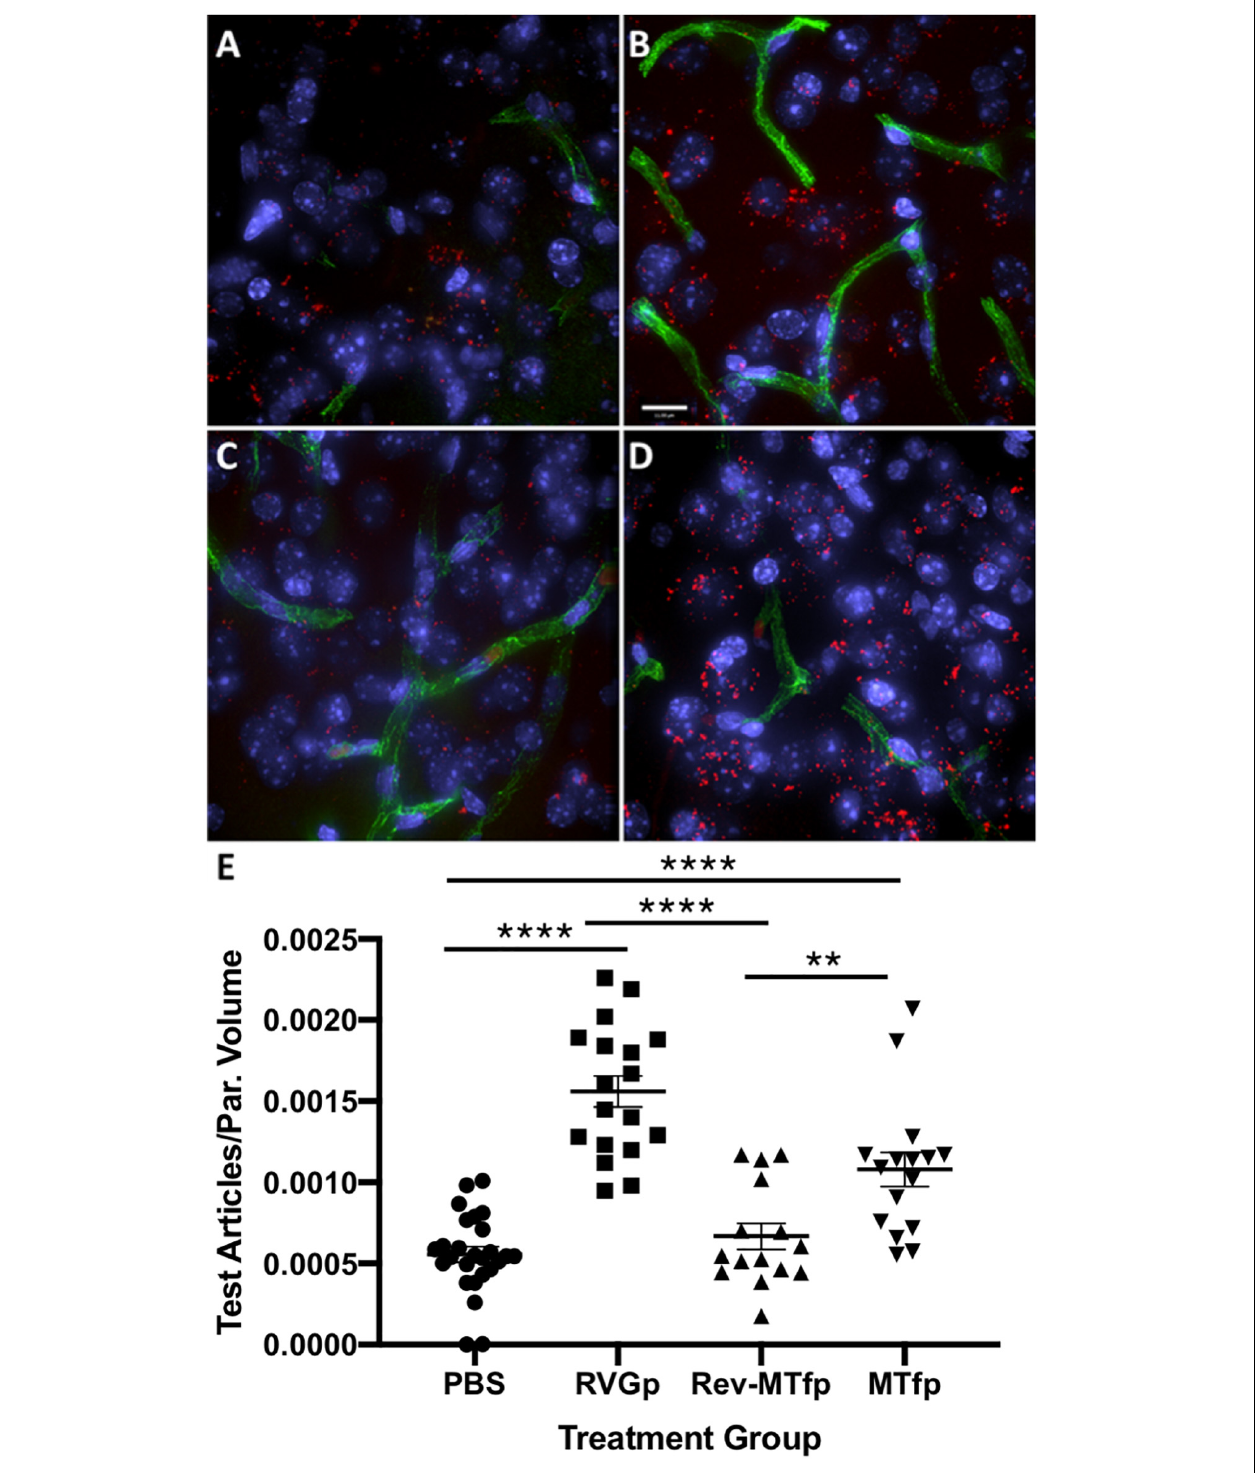
FIGURE 1 | Representative deconvolved images showing localization of MTfp in the brains of mice. Cell nuclei are blue (DAPI) and capillaries are green (FITC). (A) Fluorescence (red) in the brain for a mouse treated with PBS (i.e., background fluorescence), (B) Cy5 fluorescence in the brain after IV injection with RVGp-Cy5, (C) Cy5 fluorescence in the brain after IV injection of revMTfp-Cy5, (D) Cy5 fluorescence in the brain after IV injection of MTfp-Cy5, (E) brain distribution of Cy5 in wild type mice, where values indicate total volume of Cy5 fluorescence in each tissue normalized to tissue volume (VTA B PV in Supplementary Table 1 ). Data are shown as individual points with the error bars indicating means ± SEM ( n = 3, 3 sections/animal and 4–11 fields of view per section). ** p < 0.01, **** p < 0.0001.